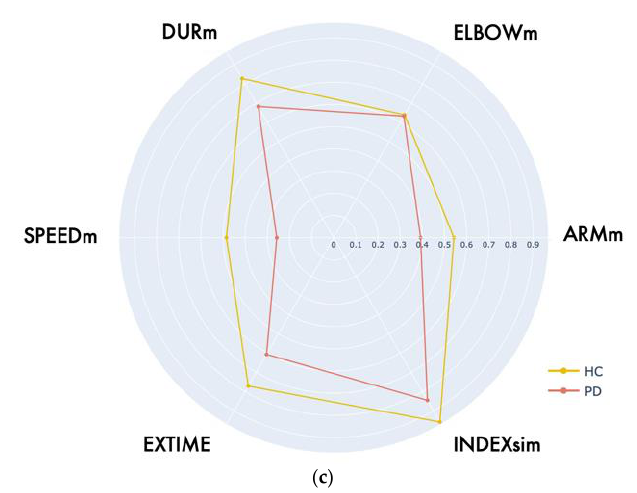
Figure 7. Radar charts of the normalized parameters of PD and HC subjects for all the exergames: ( a ) Bouncing Ball; ( b ) Lateral Weightlifting; ( c ) Frontal Weightlifting.